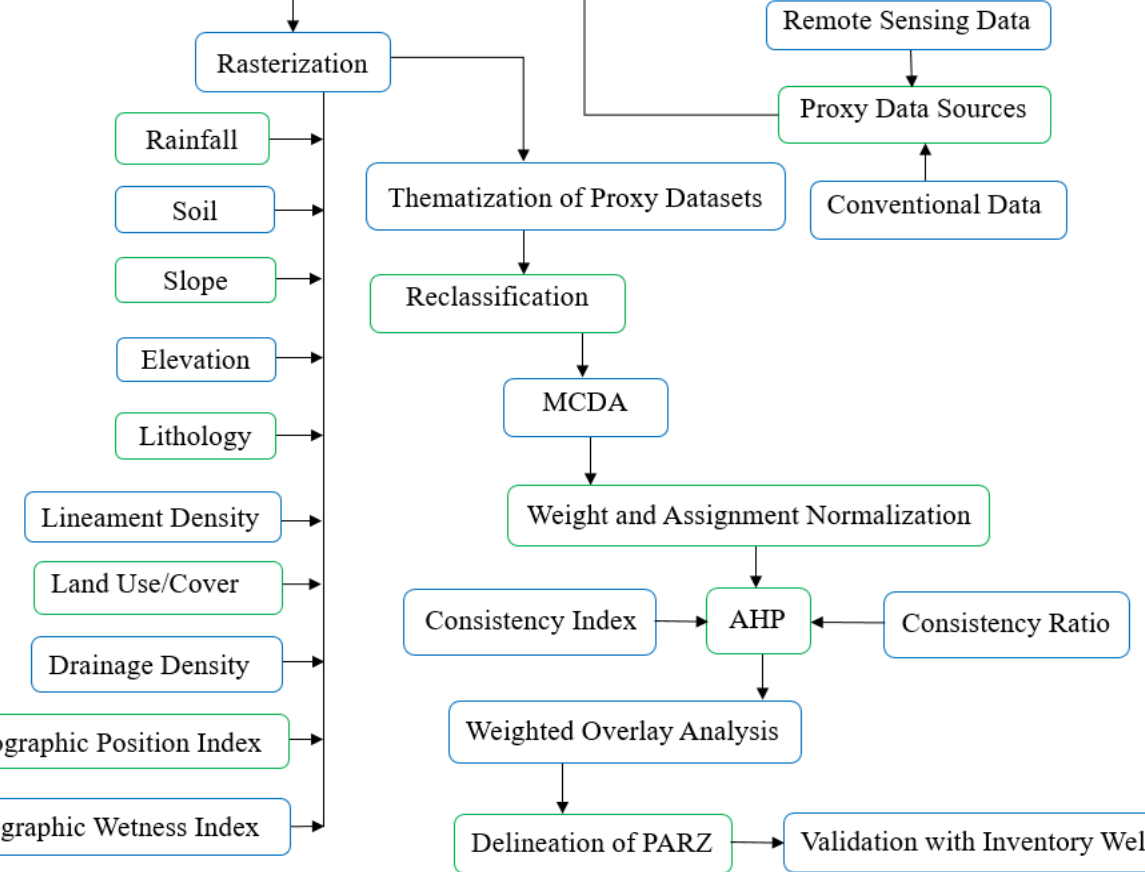
Figure 2. General flowchart of study methodology.